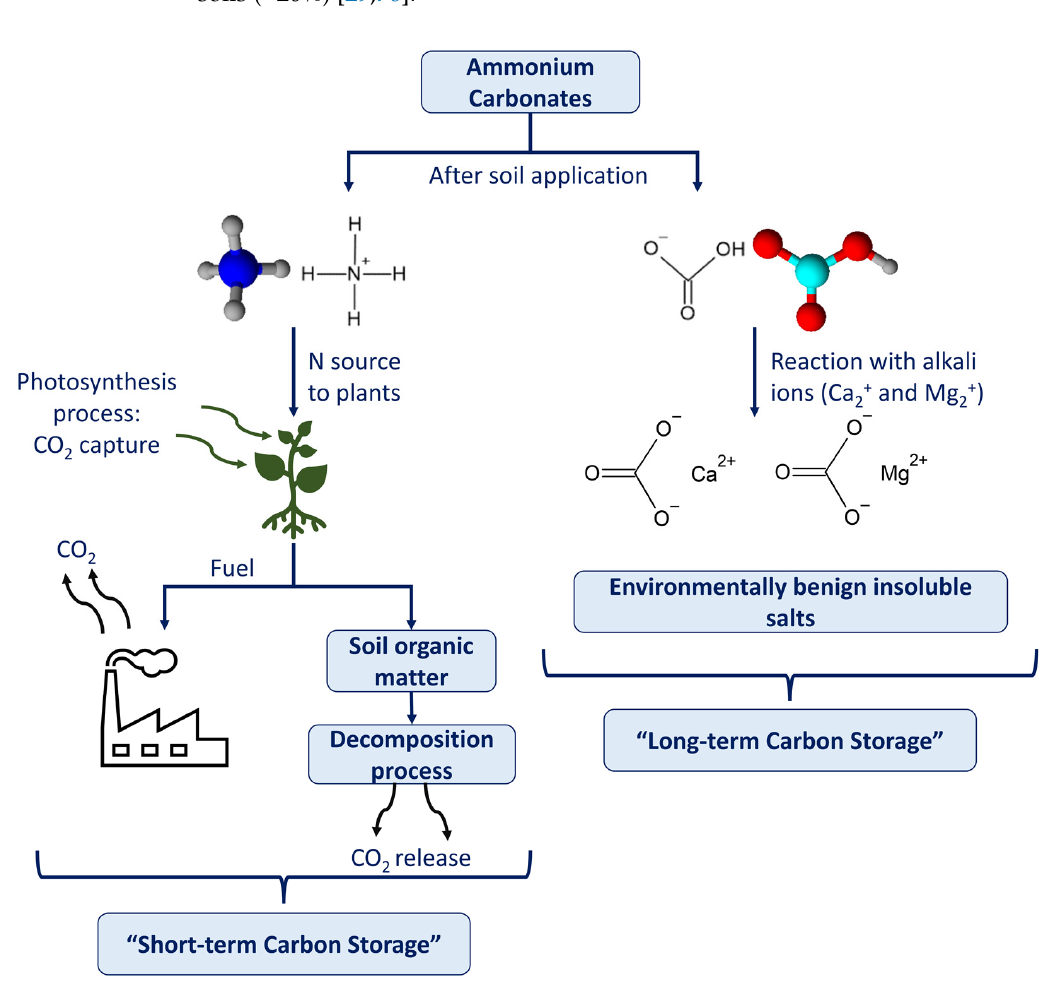
Figure 9. Ammonium carbonate effect on carbon dioxide sequestration. Compiled from [29,76].